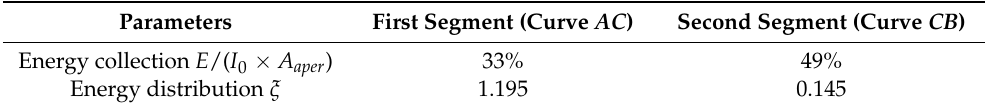
Figure 12. Energy distribution after modularization: ( a ) the first segment (curve AC ); ( b ) the second segment (curve CB ). Table 3. Detailed values of energy collection and distribution. Table 3. Detailed values of energy collection and distribution.